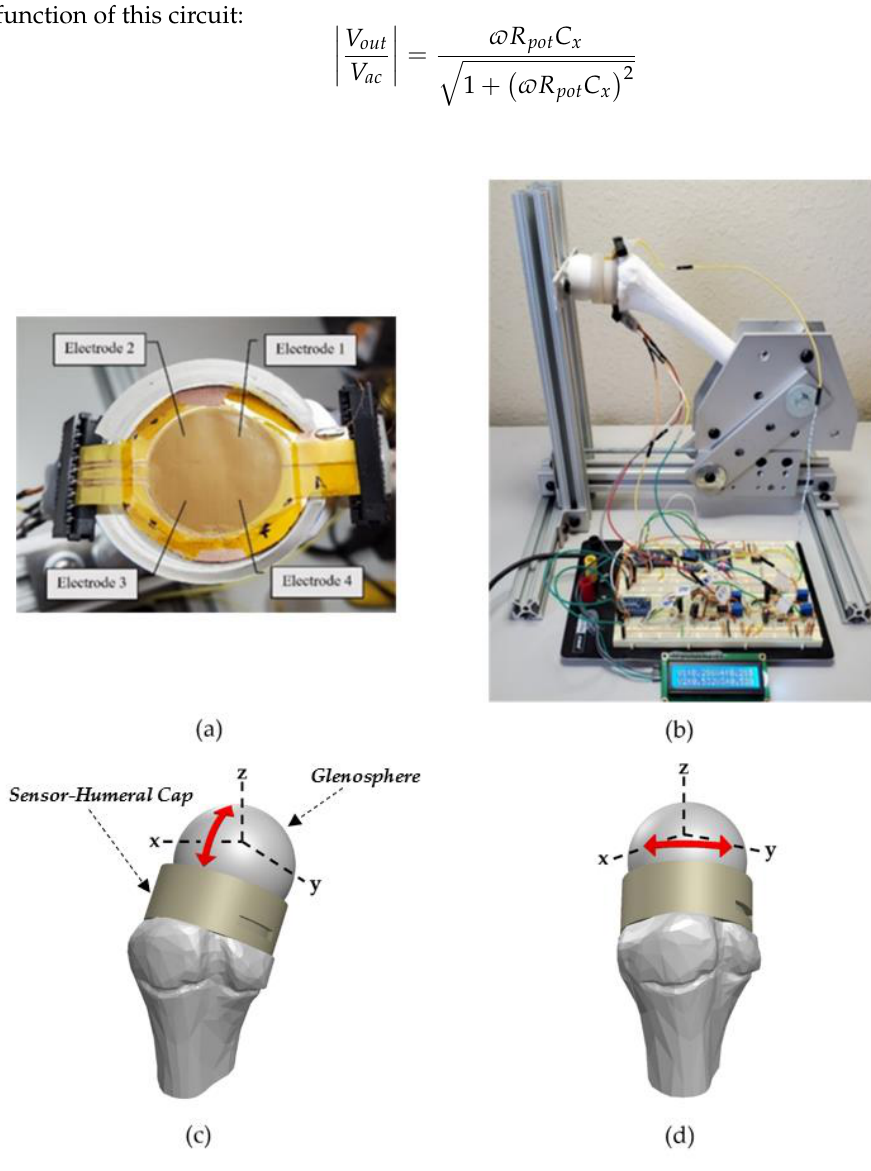
Figure 3. ( a ) Capacitive sensing array fixed inside the 3D printed humeral cap. ( b ) Testing configuration. ( c ) Sensor–humeral schematic highlighting the two positions used for results section 3.3 ( d ) Sensor–humeral schematic highlighting the two positions used for results section 3.3.